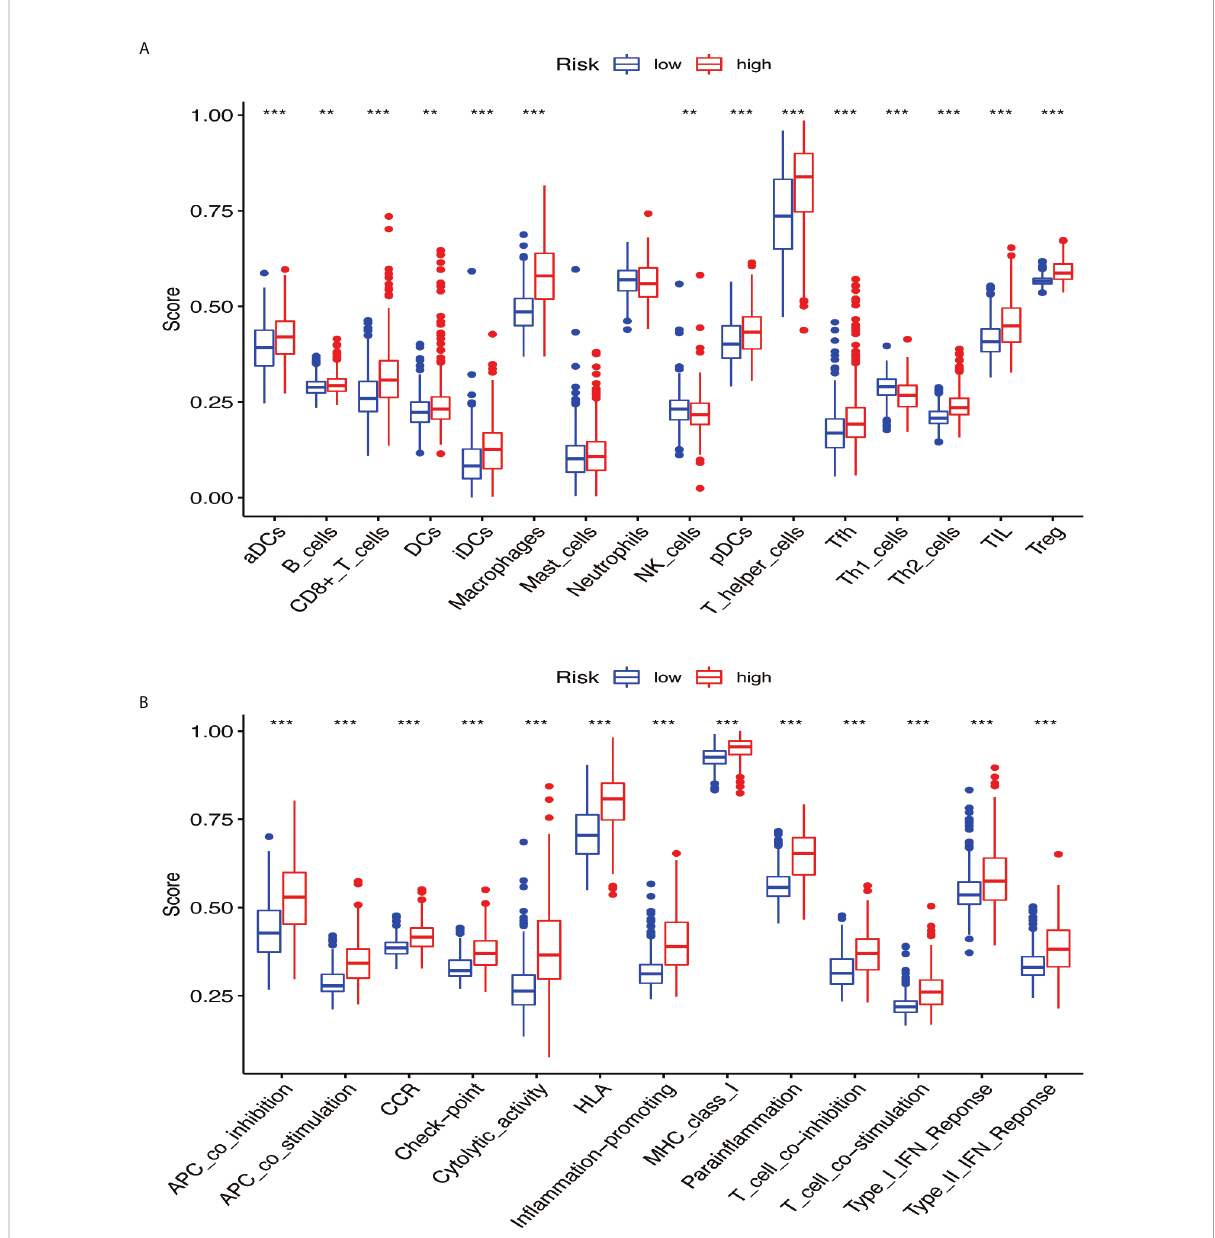
FIGURE 9 The immune pathways and underlying mechanisms. (A) Two immune cells were not related to patient risk score, three immune cells showed a higher degree of in fi ltration in the low-risk group, and 11 immune cells showed a higher degree of in fi ltration in the high-risk group. (B) Thirteen immune functions were identi fi ed. ** if p < 0.01, and *** if p <